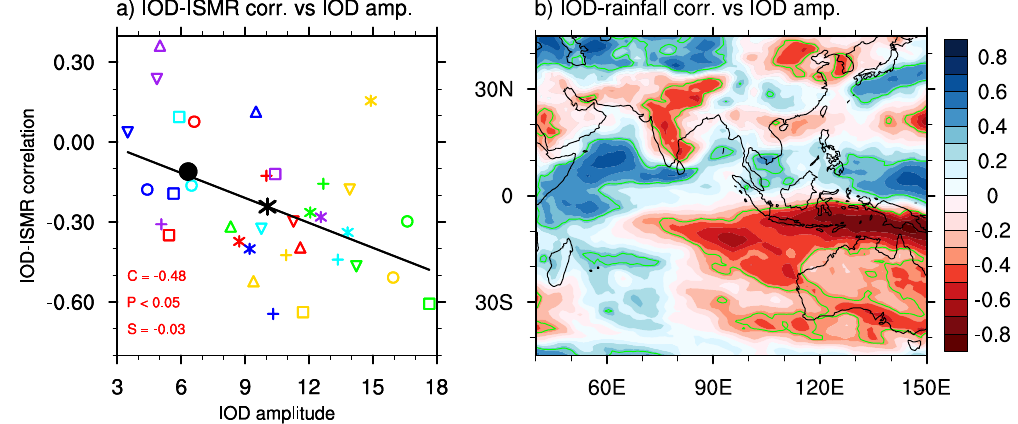
Figure 2. Inter-model simulations of present-day IOD properties. Inter-model variations in IOD amplitude (units: °C) versus variations in ( a ) IOD-ISMR correlation and ( b ) IOD-rainfall correlation in each grid point for the present-day climate. In ( a ), the linear regression line (black) with slope (S), correlation (C), and p-value (P) provided; the observed (MMEM) is indicated by a black circle (asterisk); and each model is represented by a colored symbol (see Fig. 3 for model names). The green contours in ( b ) denote areas where the correlation is statistically significant above the 95% confidence level. The significance is calculated using a two-tailed Student’s t -test. The plot and map were generated by NCL version 6.3.0